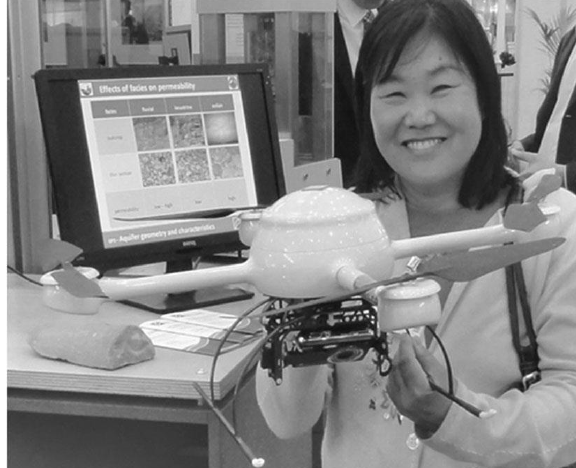
figure 7. Down in Magdeburg in addition to the carbon rod a captive balloon and nowadays of course, also a hexacopter UAV- platform is in use, mainly to take better (extremely low altitude, ground truth) synoptically aerial 3D photography, see figure 8. Additional experiments with respect to multistage concepts of 3D photographs in Cultural heritage, like combining 3D imagery showing differences in focus, daytime, spectral characteristic etc., just started.